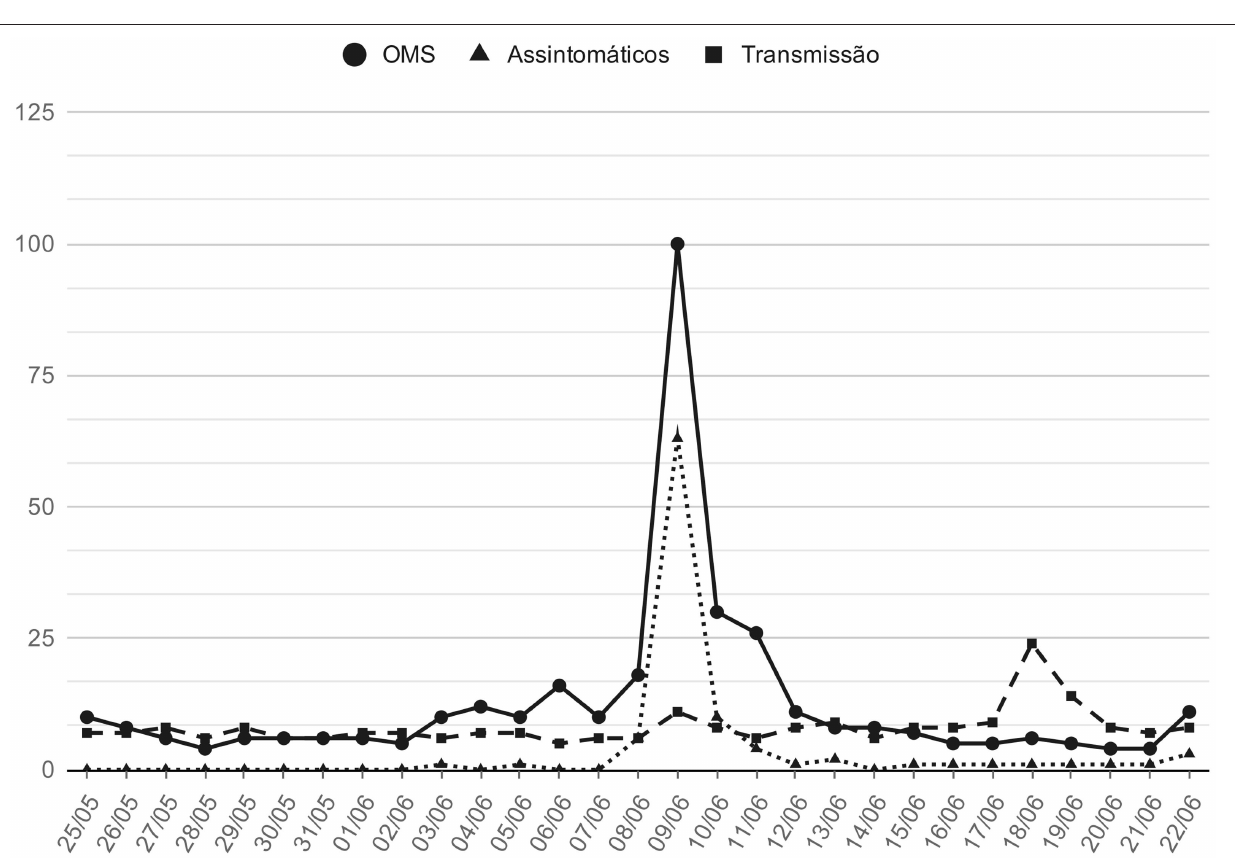
top 10 posts on this issue—even one from a far right- wing representative, Joice Hasselmann, who was until 2020 a Bolsonaro supporter—used a frame showing that intolerance disguised as love for homeland allowed political radicalism to overcome humanity or compassion. A related frame highlighted the lack of empathy toward professionals who should be acknowledged as